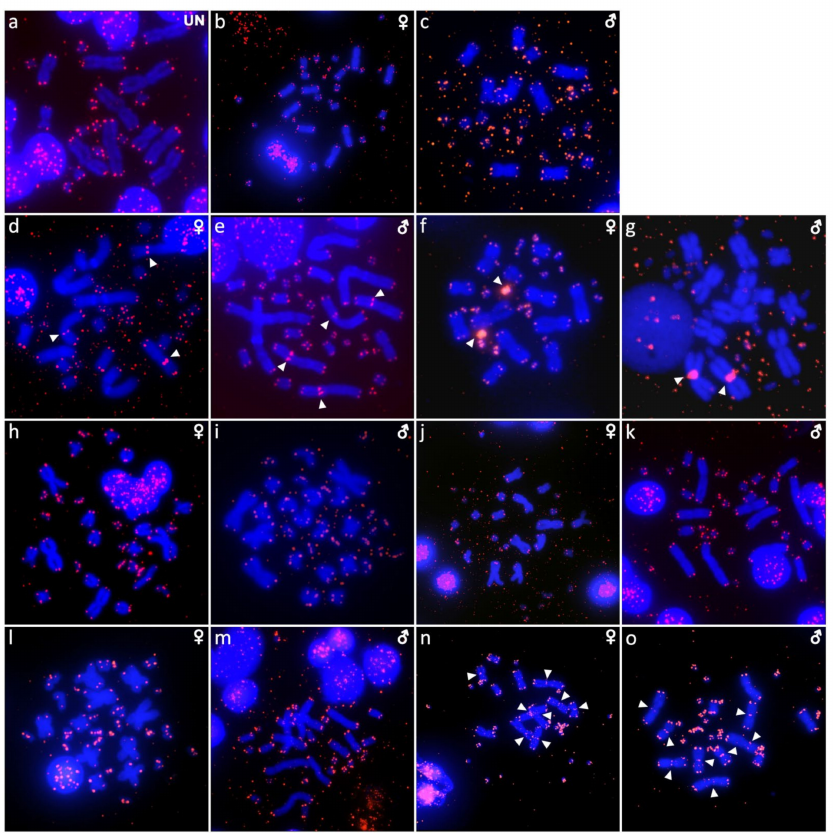
Figure 4. In situ hybridization with probe for telomeric sequences in Acontias percivali ( a ), Cyclodomorphus gerrardii ( b , c ), Eutropis multifasciata ( d , e ), Platysaurus sp. 1 ( f ), Platysaurus sp. 2 ( g ), Scincopus fasciatus ( h , i ), Tiliqua gigas ( j , k ), Tiliqua scincoides ( l , m ), and Tracheloptychus madagascariensis ( n , o ). UN: sex not